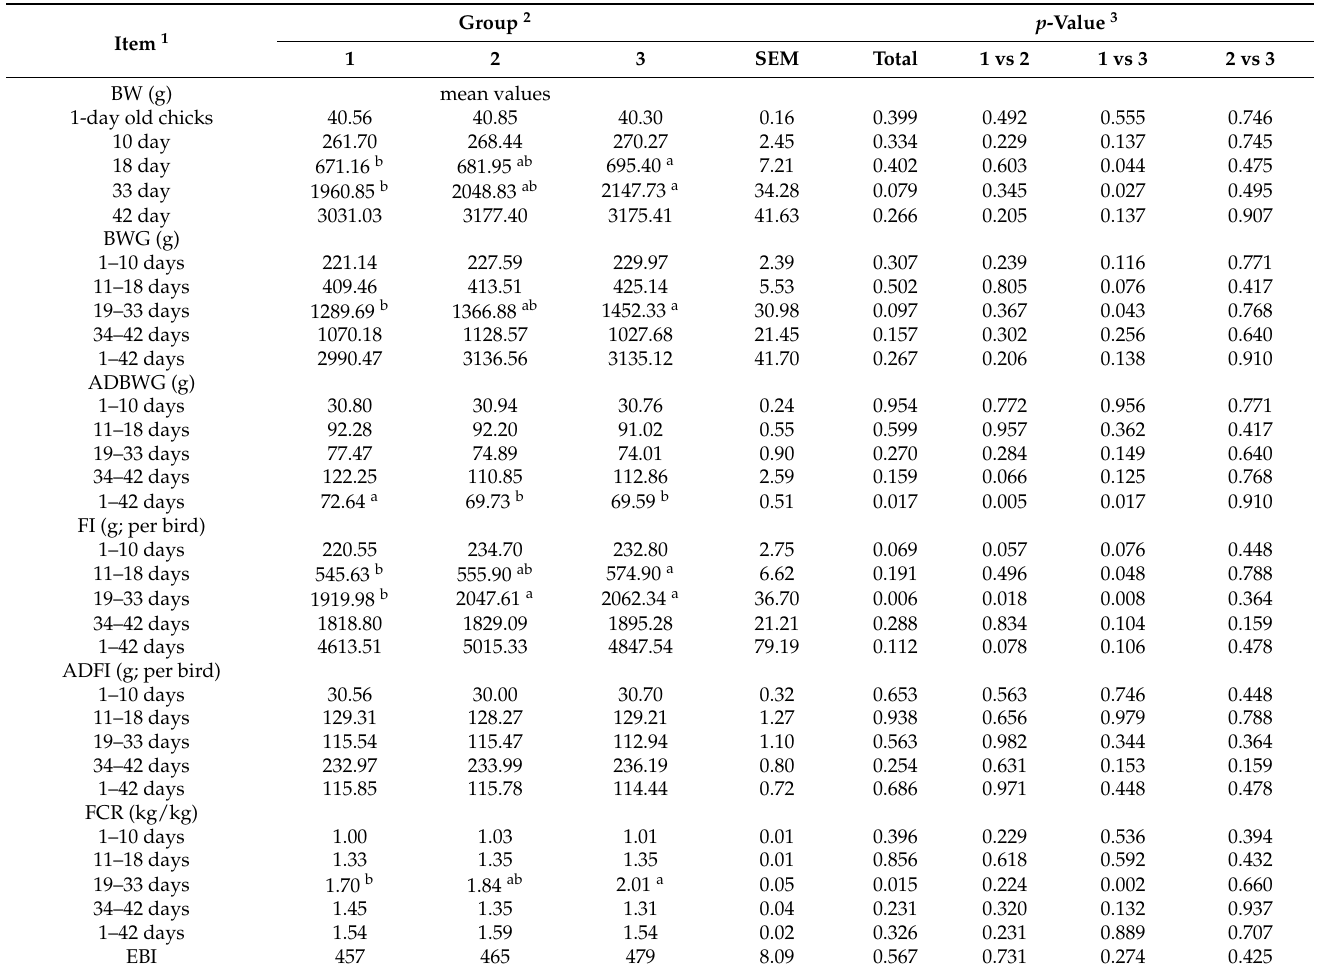
Table 3. Growth performance of broiler